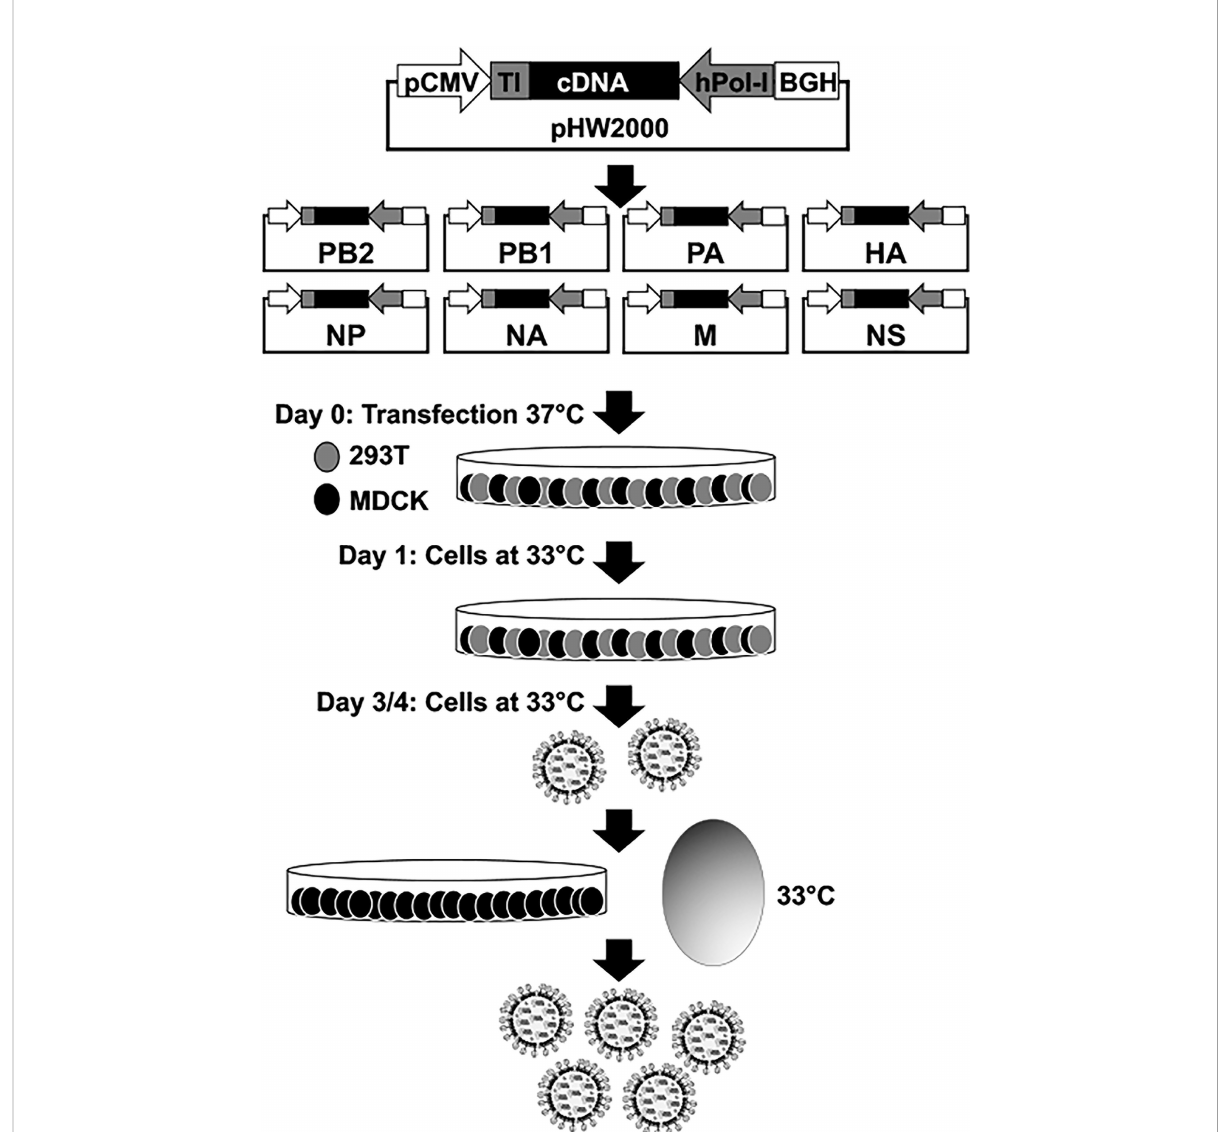
FIGURE 2 Plasmid-based reverse genetics approach for the recovery of recombinant IAV. Schematic representation of the ambisense plasmid used to generate recombinant IAV is shown in the top. IAV cDNAs are cloned into the plasmid fl anked by the human polymerase I promoter (hPol-I, gray arrow) and the mouse Pol-I terminator (TI, gray box) sequences to drive the synthesis of the vRNAs. In opposite orientation to the polymerase I cassette is the polymerase II (Pol-II) cassette made of a Pol-II dependent cytomegalovirus promoter (pCMV, white arrow) and the polyadenylation sequence of the bovine growth hormone (BGH, white box) to allow the expression of viral proteins from the same viral cDNAs. Co-cultures of human 293T (gray) and canine MDCK (black) cells are co-transfected with the eight (PB2, PB1, PA, HA, NP, NA, M, and NS) ambisense plasmids. Recovered virus is ampli fi ed in fresh cells or embryonated chicken eggs for vaccine production. Since NS1 truncated or de fi cient IAV have a ts phenotype, virus rescue and ampli fi cation is carried out at